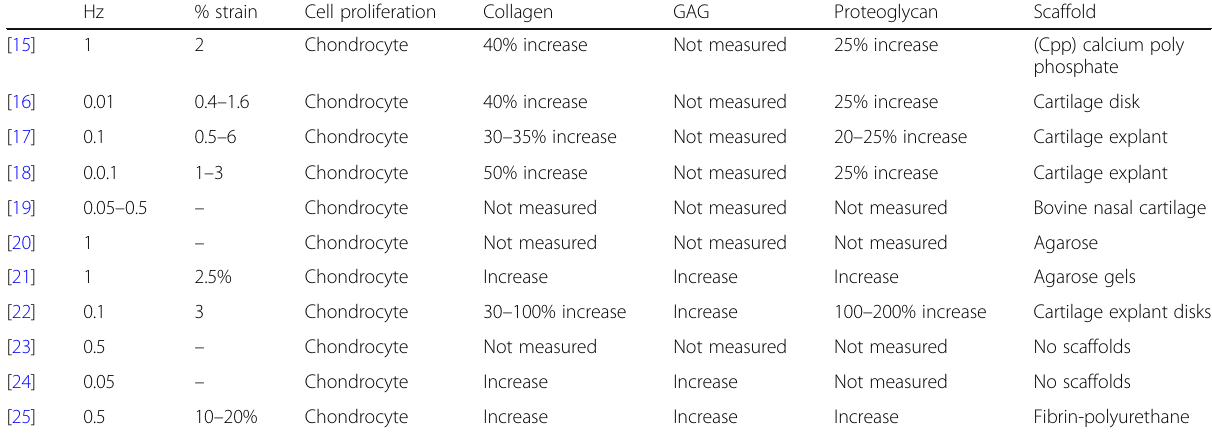
Table 5 Effect of experimental contact shear on chondrocyte proliferation and matrix composition